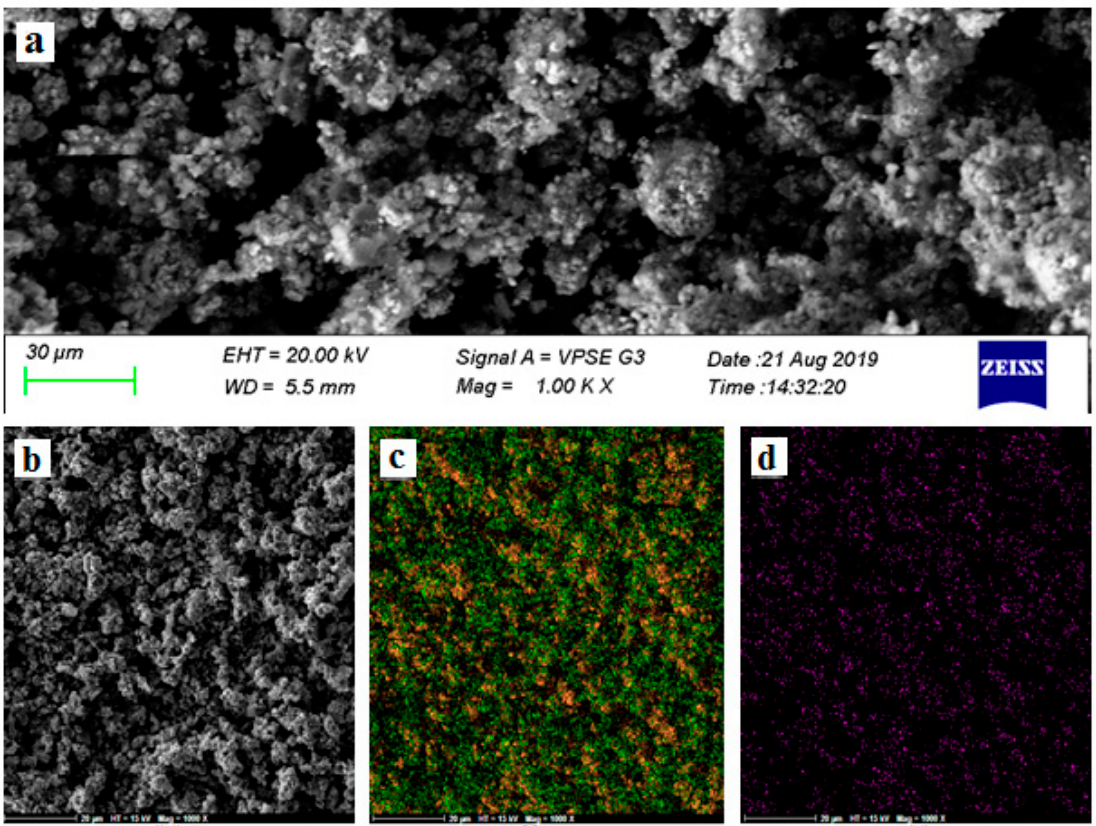
Figure 2. ( a ) SEM images of Fe3C@N-GE-Fe3O4 hybrid. FESEM-EDS images of ( b ) catalyst surface, ( c ) iron and ( d ) nitrogen elemental distribution.